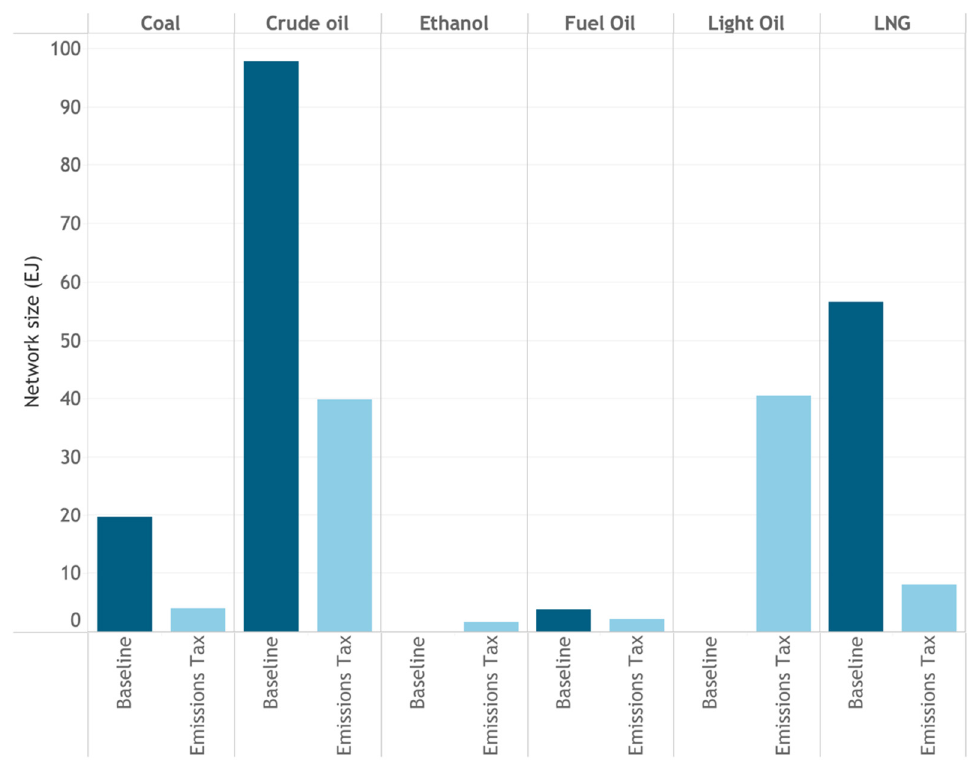
Figure 5. Total global trade size by energy commodity in 2050 in baseline and emissions tax scenarios.